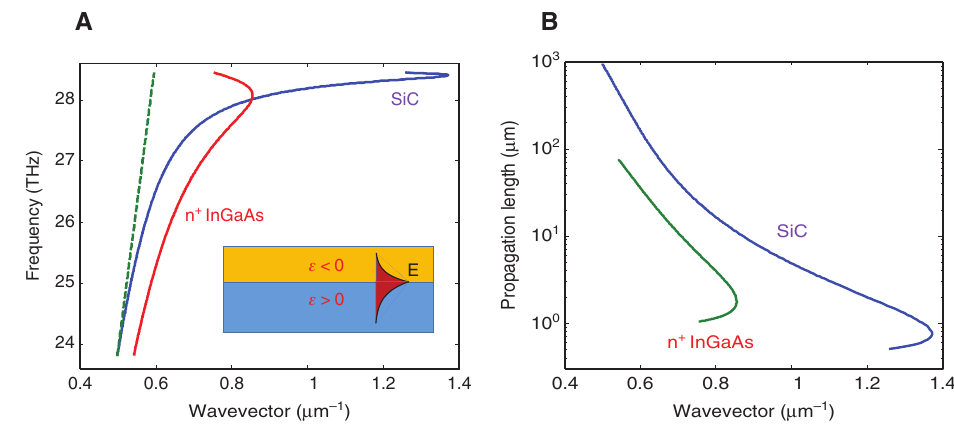
Figure 5: Comparison of propagating surface phonon (SiC) and surface plasmon (InGaAs) polaritons. (A) Dispersion curves. The dashed line represents the light line in the cladding (B) Propagating lengths vs.